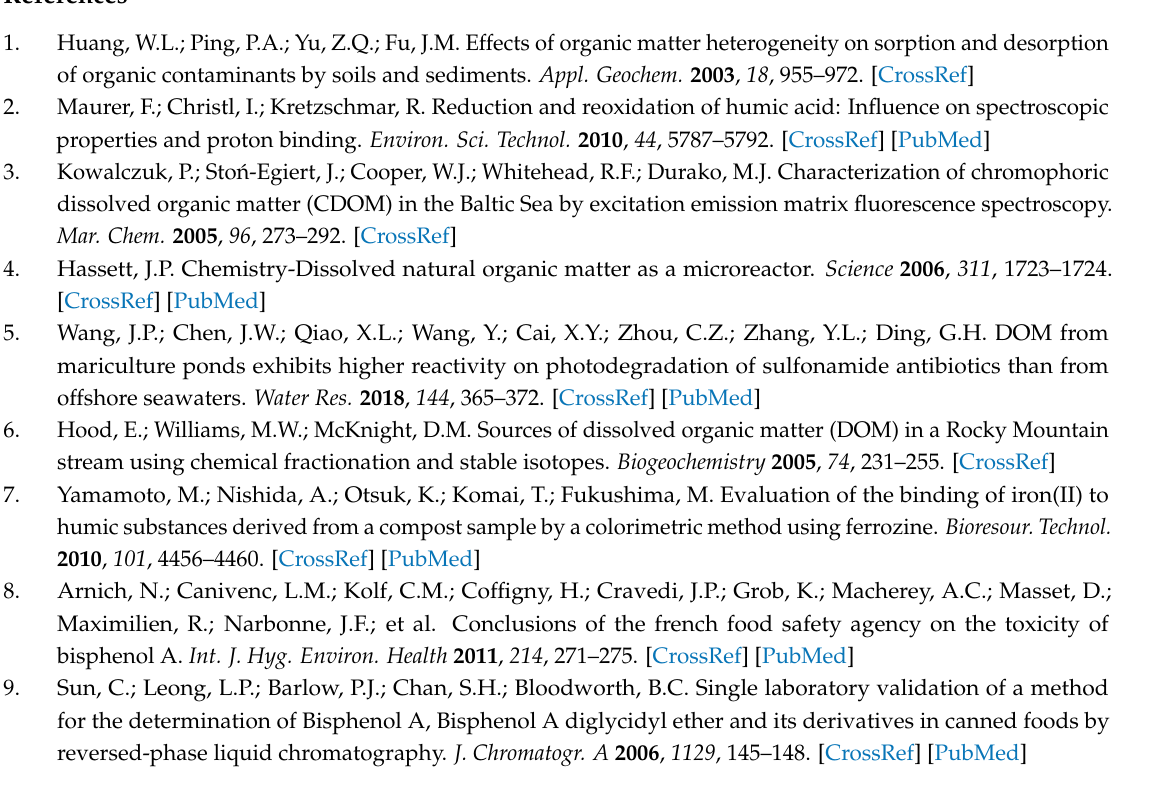
Figure S1: Molecular structures of BPa and BPs, Figure S2: The pseudo-second-order kinetic fitting line, Table S1: Physicochemical properties of the soil sample and biochar sample, Table S2: The ratio of fluorescence intensity in each region to total fluorescence intensity of